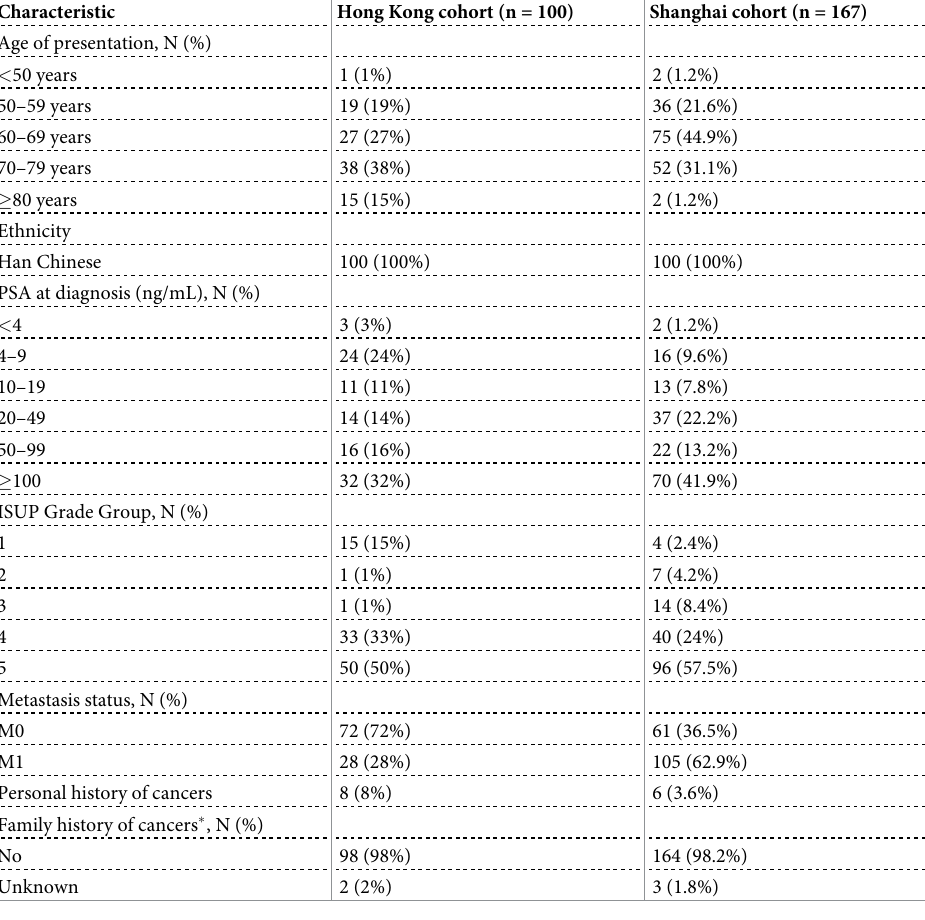
Table 1. Clinicopathological characteristics of the Hong Kong and Shanghai